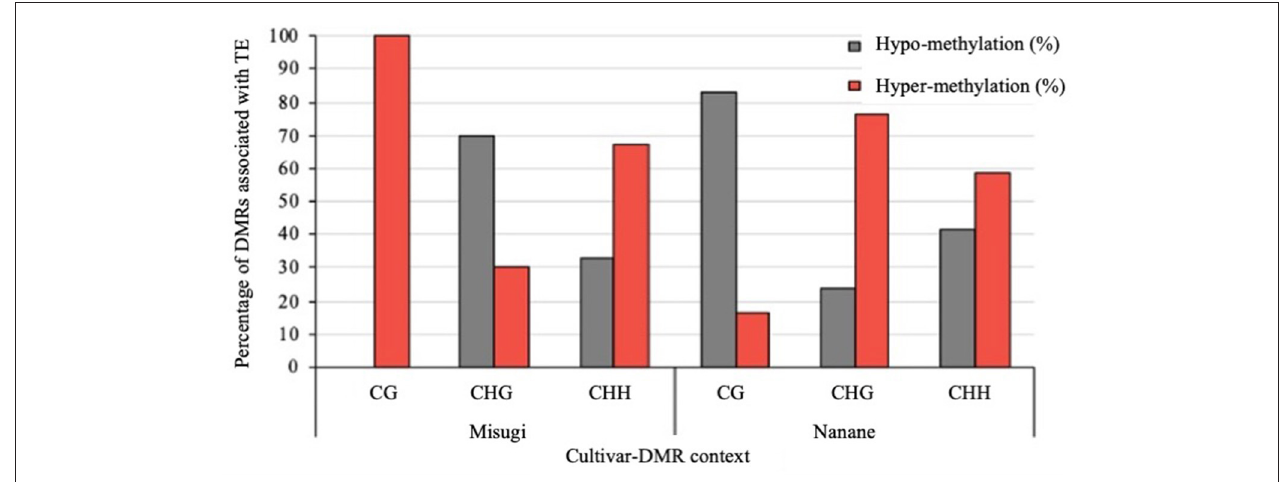
FIGURE 7 | Percentage of differentially methylated regions (DMRs), between control cotyledons and cotyledons infected with A. candida , associated with transposable elements (TEs) at each methylated context in B. rapa cultivars “Misugi” (susceptible) and “Nanane” (resistant).